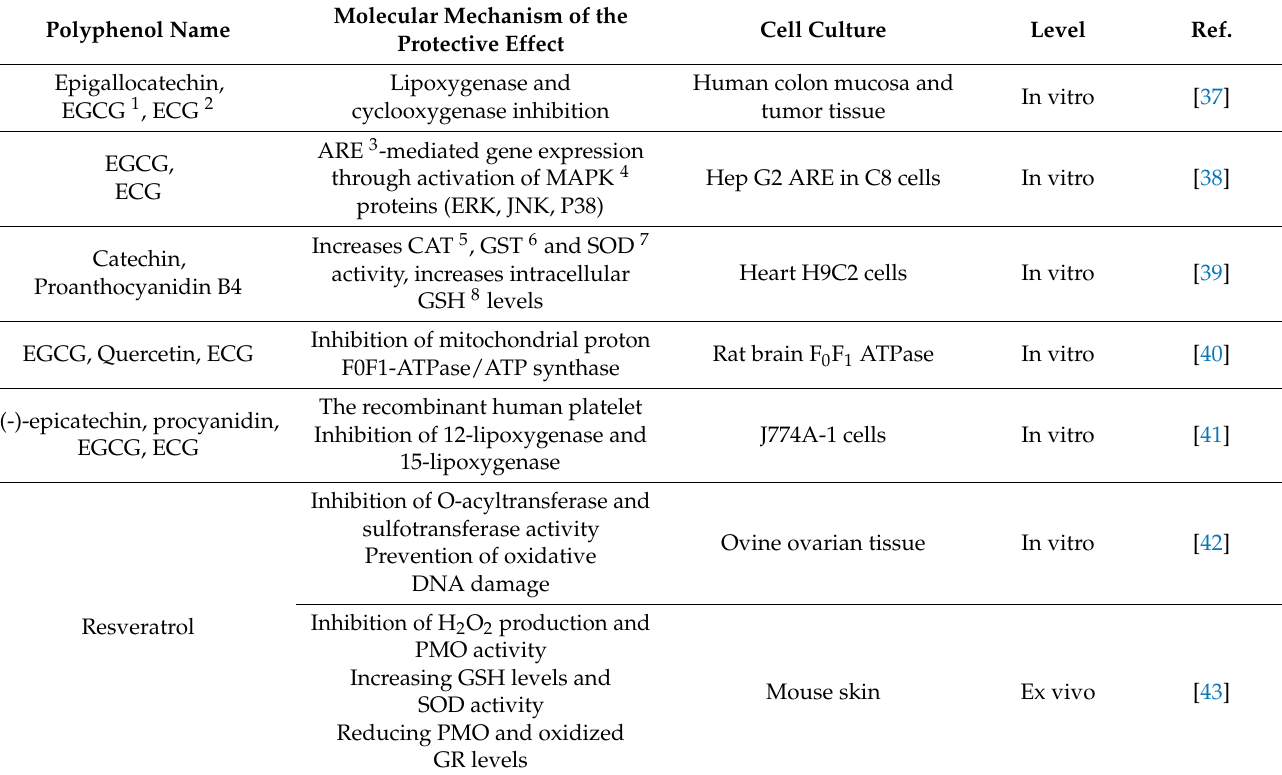
Table 5. Antioxidant and free radical scavenging properties of polyphenols isolated from grape marc (grape seeds and grape